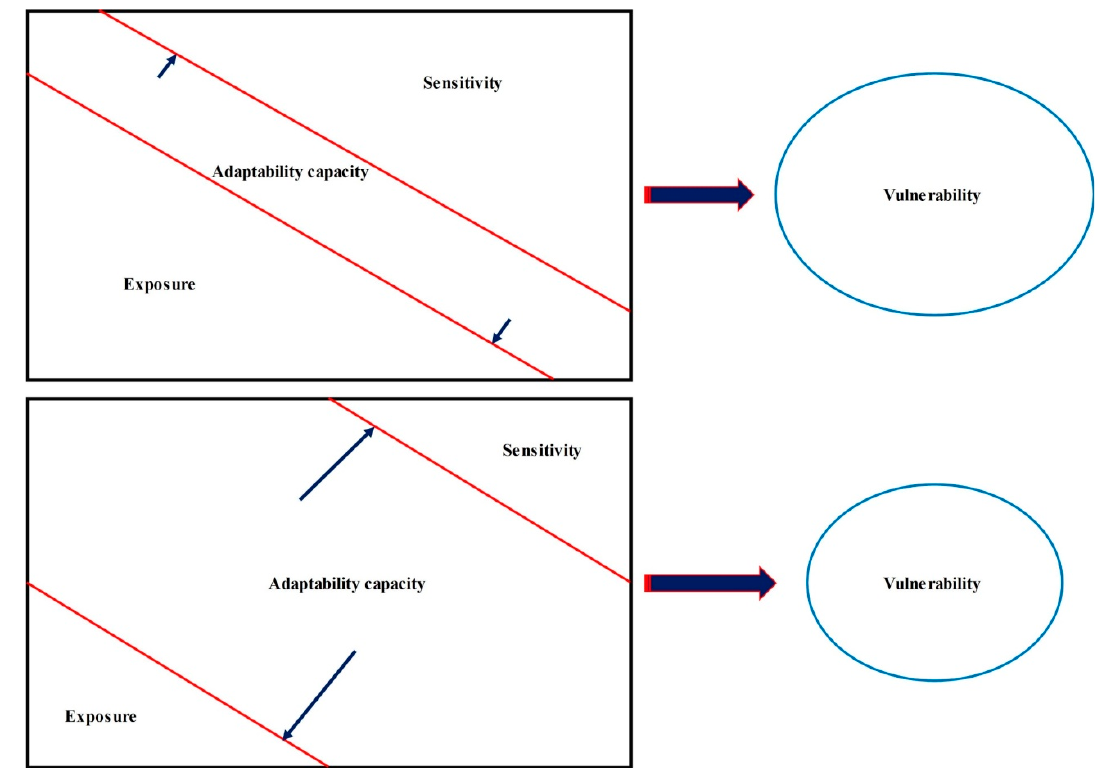
Figure 1. The effect of adaptability capacity on vulnerability [65].